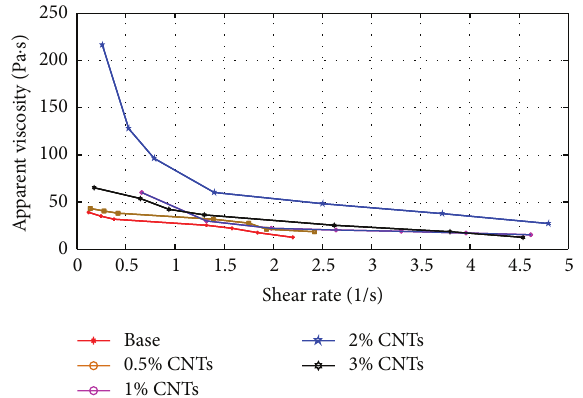
Figure 5: Apparent viscosity of the grease